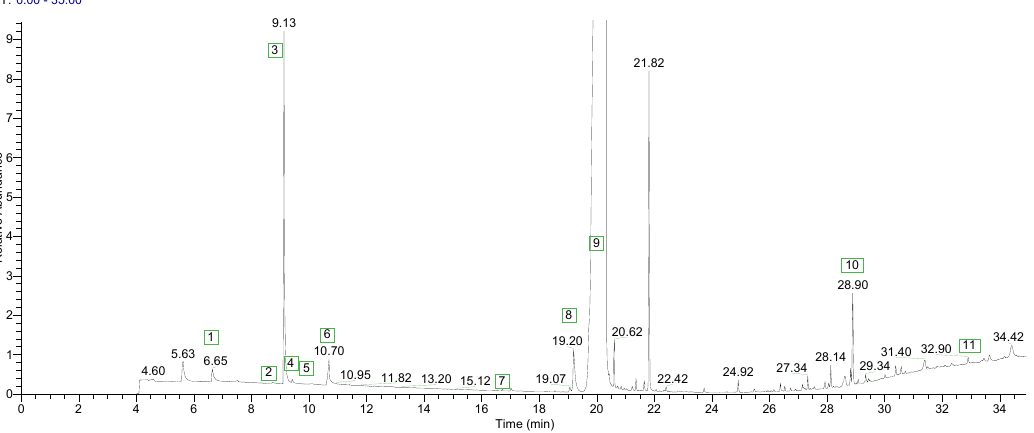
Figure 1. GC ‐ MS total ion current chromatogram of UV ‐ exposed PI 10. Photolytic decomposition Figure 1. GC-MS total ion current chromatogram of UV-exposed PI 10. Photolytic decomposition